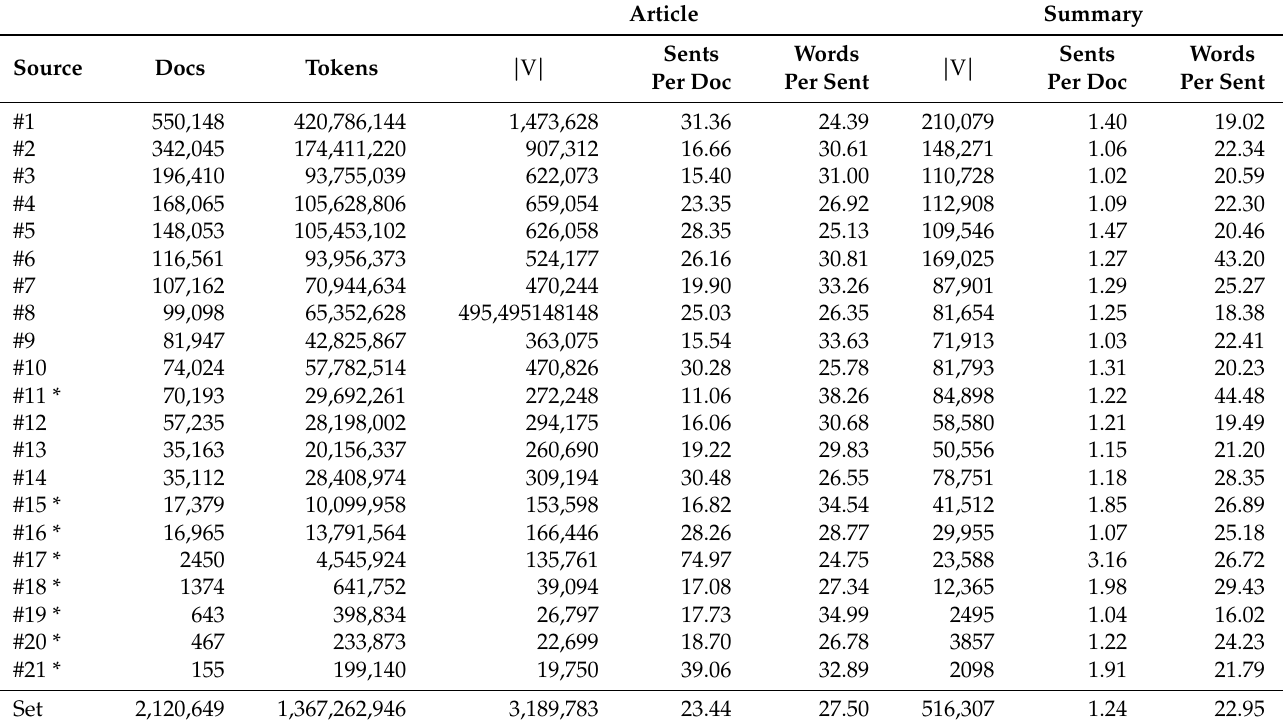
Table 2. Statistics of Spanish set. Sources marked with * were not used for training the models.